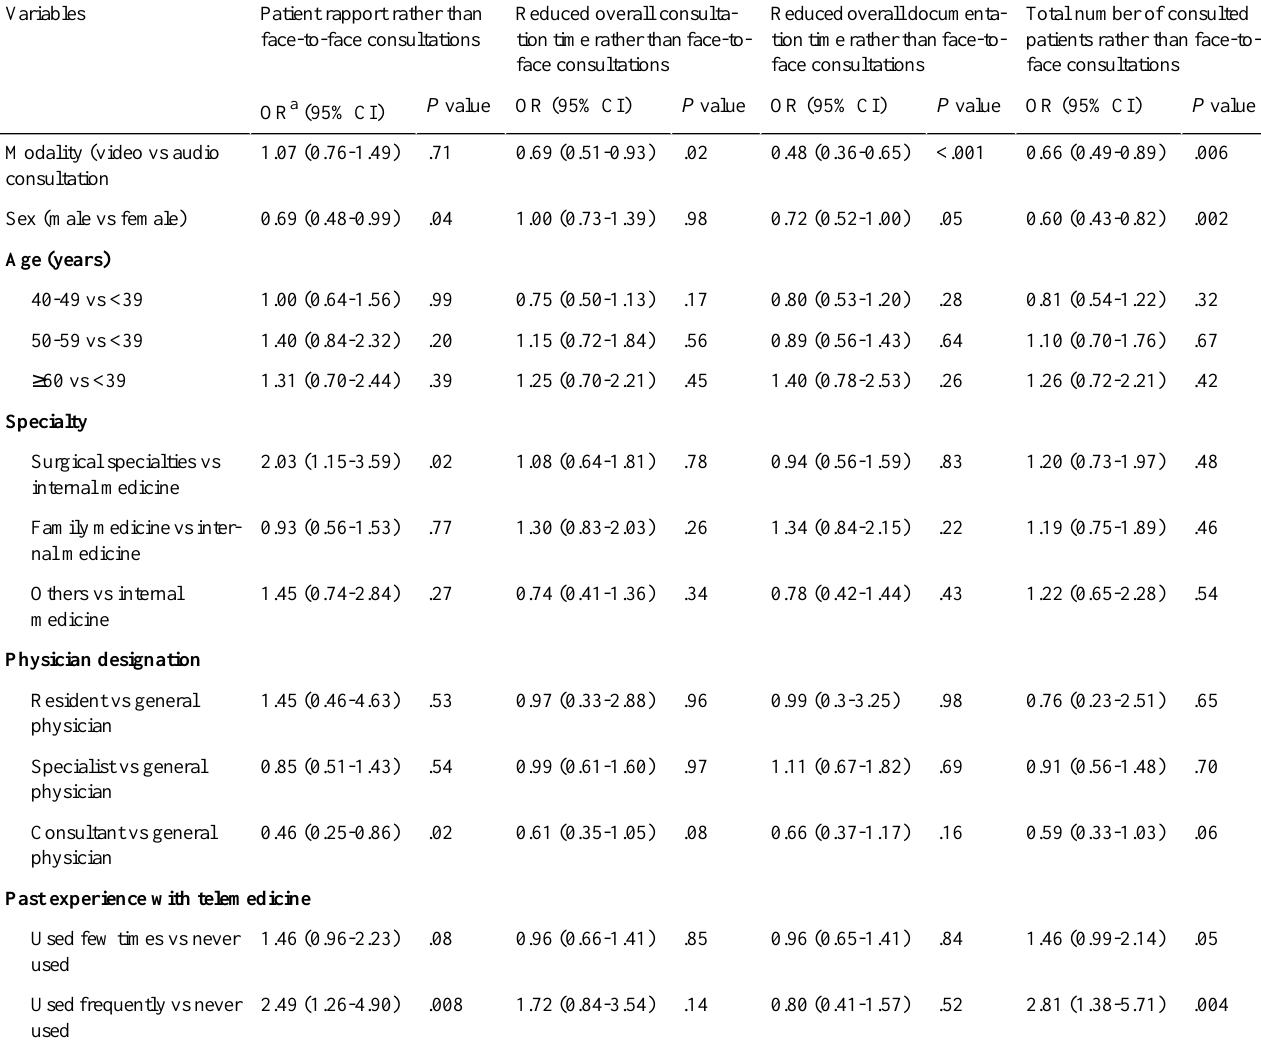
Table 5. Adjusted multivariate analysis for perceived professional productivity.